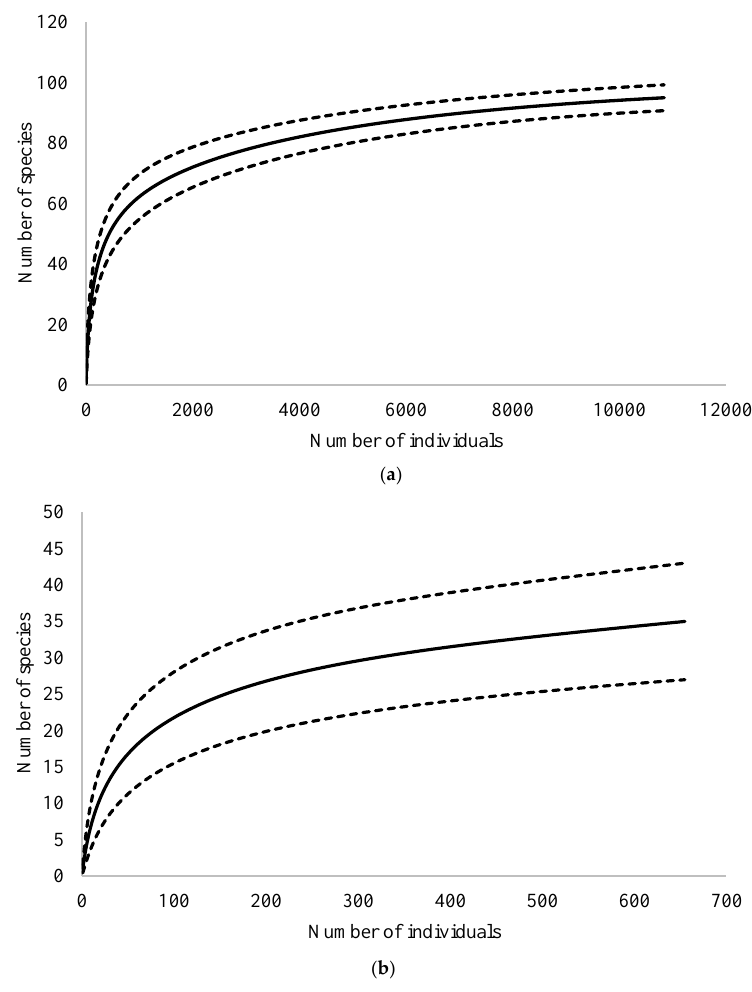
Figure 3. Rarefaction curves for Oribatida ( a ) and Mesostigmata ( b ) in broadleaf forest in Eastern Norway (continuous lines) with 95% confidence limits (broken lines). Species diversity measured with Shannon index ( H ′ ) was 2.97 for Oribatida and 2.74 for Mesostigmata. Only 30% of species (35 spp. of Oribatida and 7 spp. of Mesostigmata) were found in the broadleaf forests previously studied in Western Norway (Table 1), after